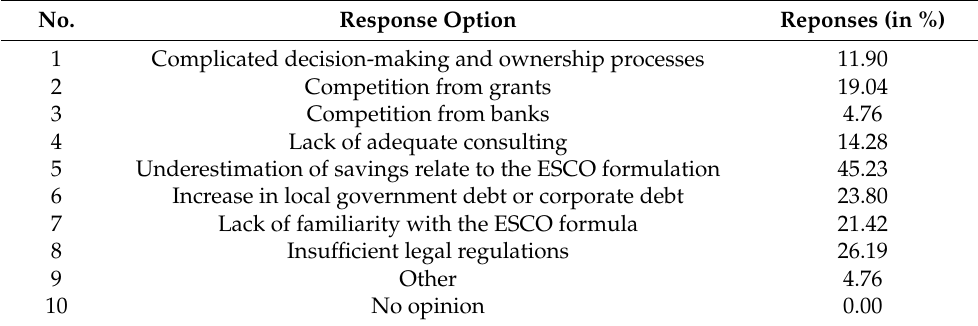
Table 5. Factors reducing interest in ESCO investments. Source: CAWI survey (multiple choice